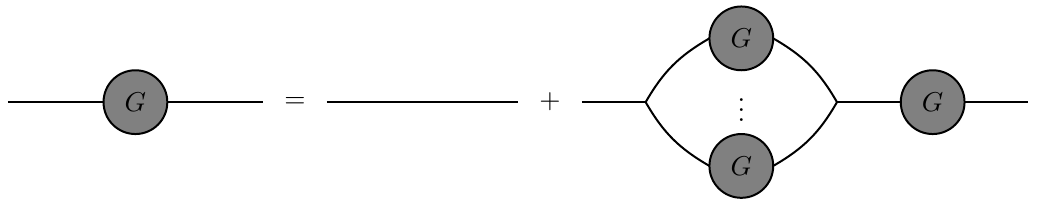
Figure 1. The leading order large N contribution to the boson propagator which leads to the Schwinger-Dyson equation